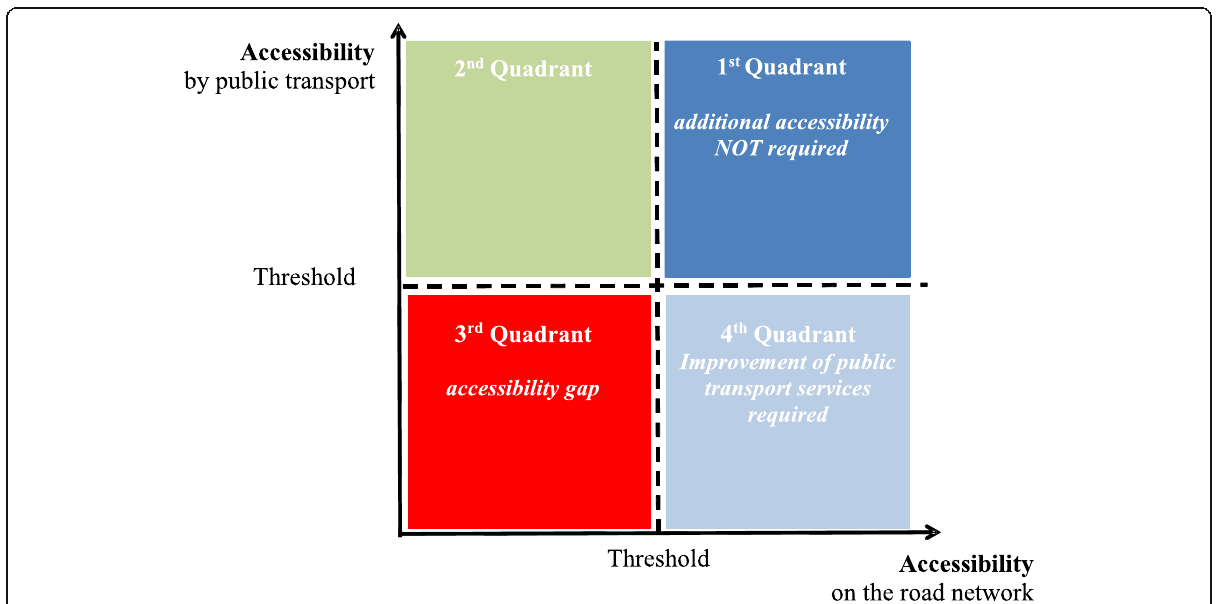
Fig. 2 the Accessibility Gap diagram for differential analysis of public vs private transport accessibility